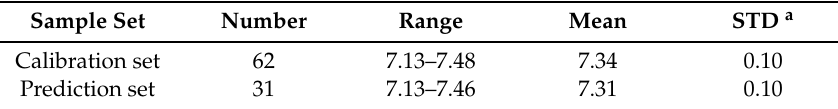
Table 1. The statistic description of sample sets split.